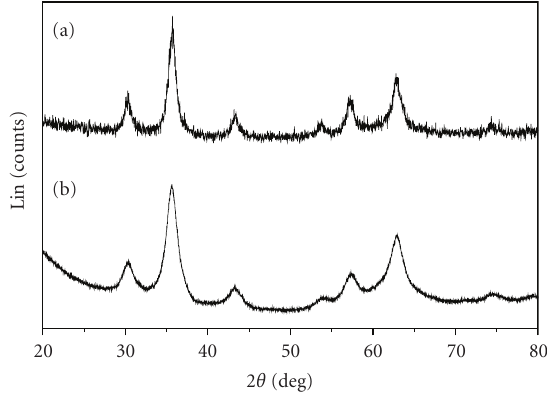
Figure 3: X-ray di ff raction patterns of 2-pyrrolidone-coated SPI- ONs (a), PVLA-coated SPIONs